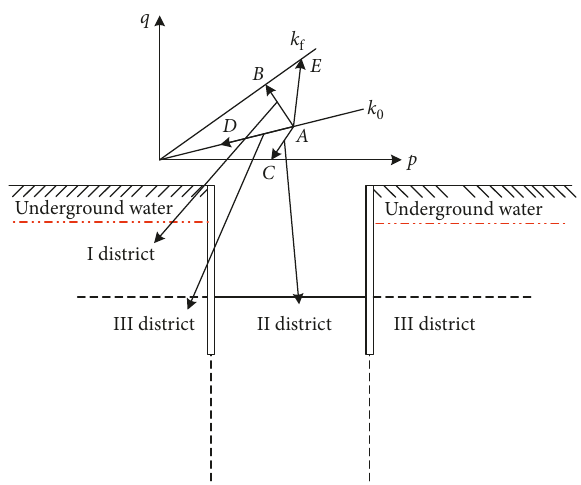
Figure 1: Schematic diagram of space excavation under soft